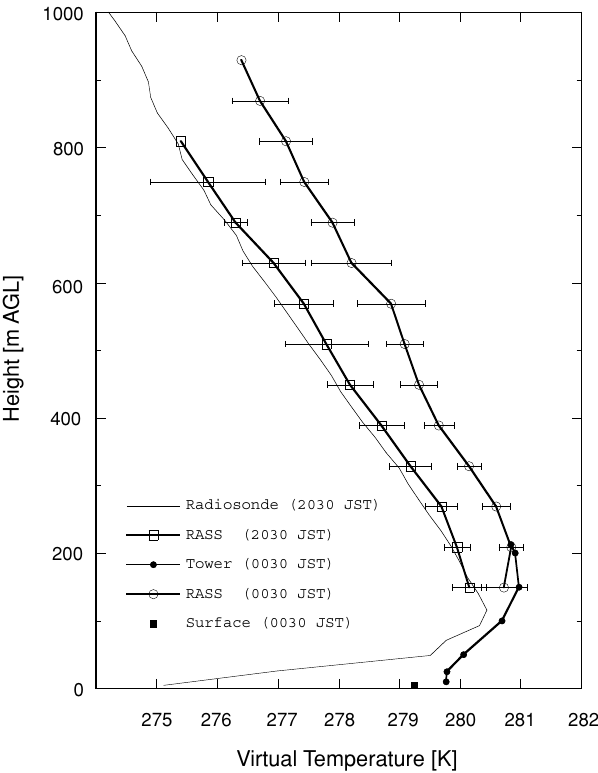
Fig. 14. Profile of virtual temperature ( T v ) from 20:30 JST on 29 December and from 00:30 JST on 30 December 1997 derived from the surface measurement, a radiosonde, the tower and RASS. The error bars represent 2 σ in RASS